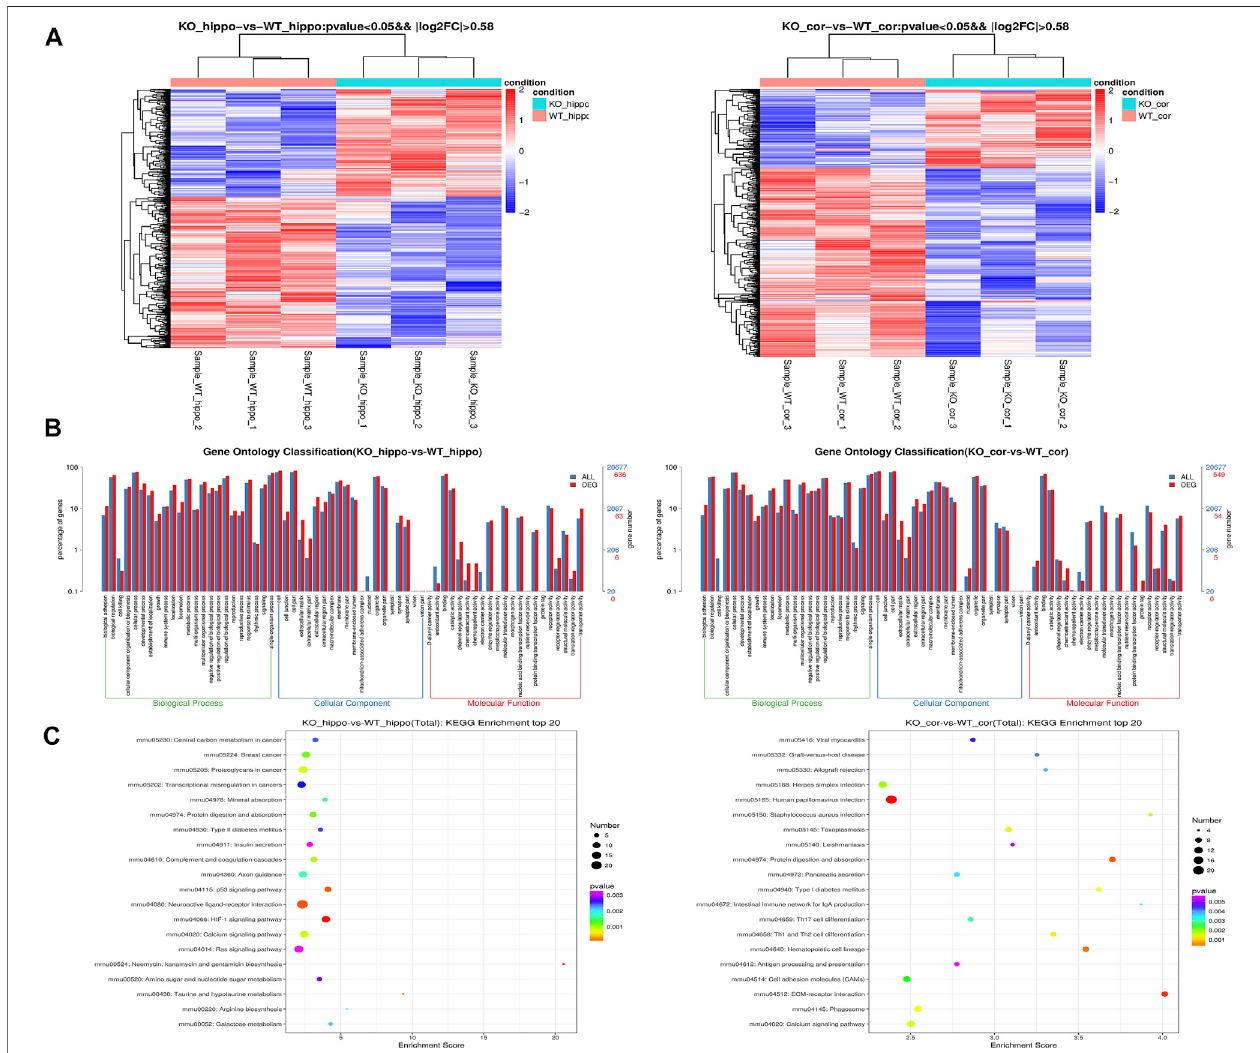
FIGURE 8 | Transcriptome pro fi ling in the hippocampus and cortex tissues of mice. (A) Heatmap of the DEGs. (B) Enriched Biological Process pathway, cellular component and molecular function in GO analysis ( p < 0.05). (C) KEGG enrichment analysis of DEGs. The intensity of the color depends on the p value. The size of plot depends on the gene count. ( n (cid:2)